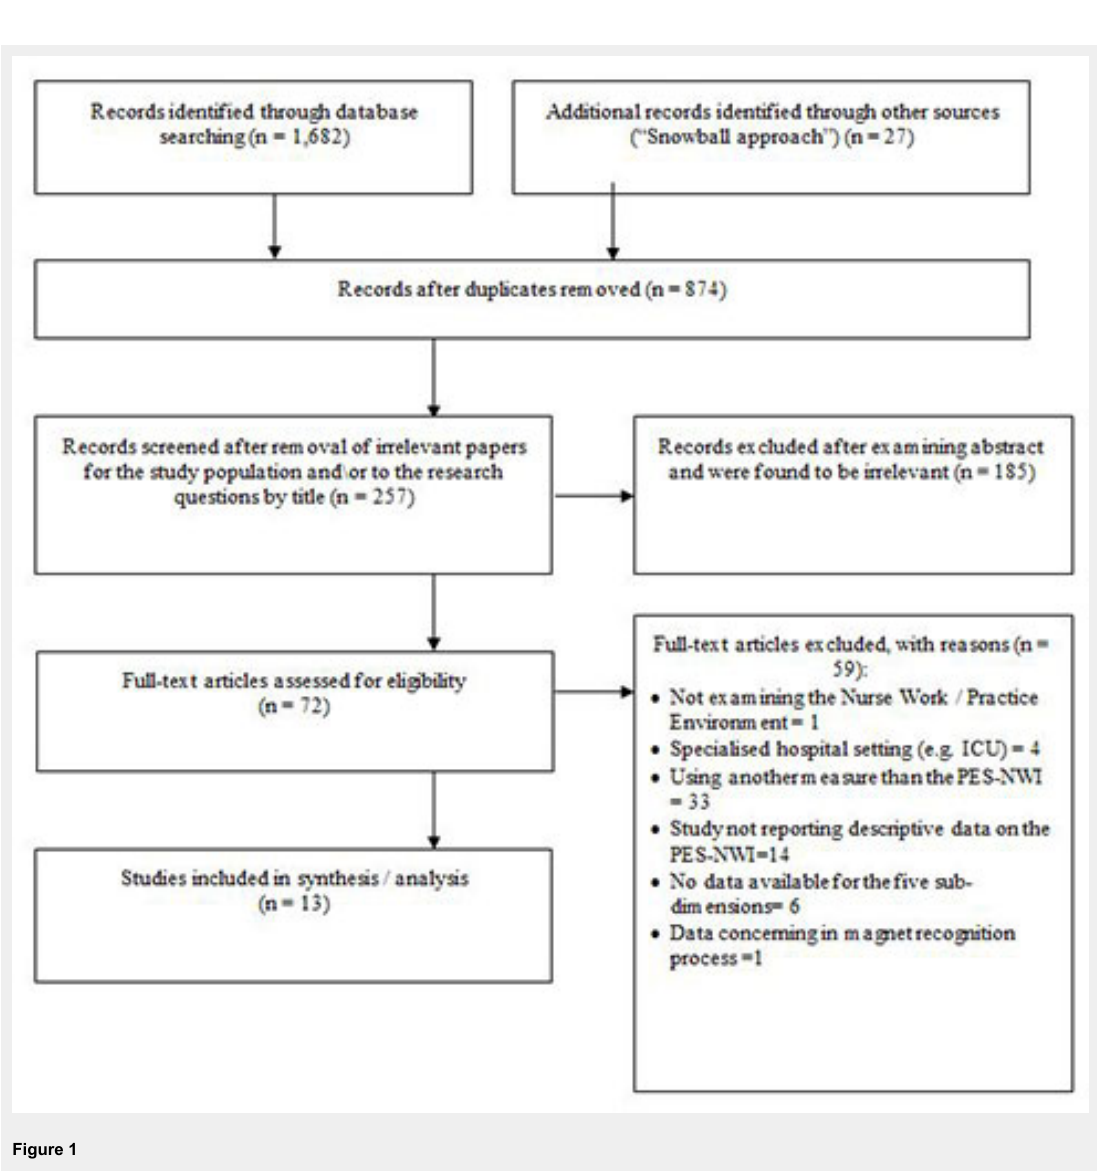
Flow diagram of study selection